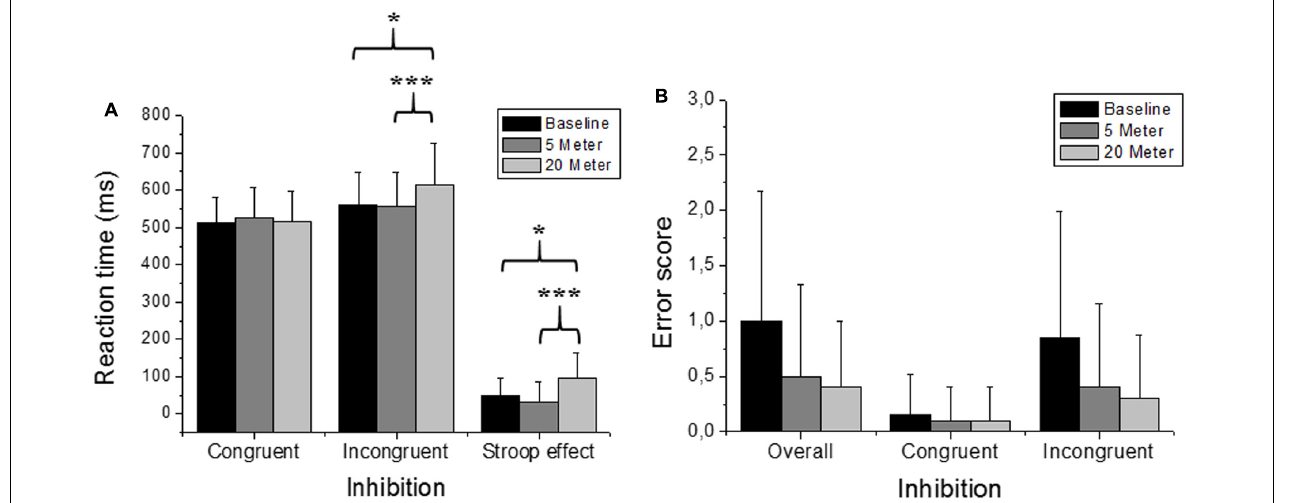
FIGURE 2 | Stroop task performance (i.e., inhibition). Depicted are mean reaction times and the mean errors. (A) Stroop task performance of the congruent and the incongruent stimuli and the resulting Stroop effect. (B) “Overall” represents all errors independent of the stimuli, while the separated errors for the congruent and incongruent stimuli are depicted as well. Values representing the arithmetic mean and error bars indicate the corresponding standard deviations. ∗ Denotes p < 0.05 and ∗∗∗ p < 0.001.